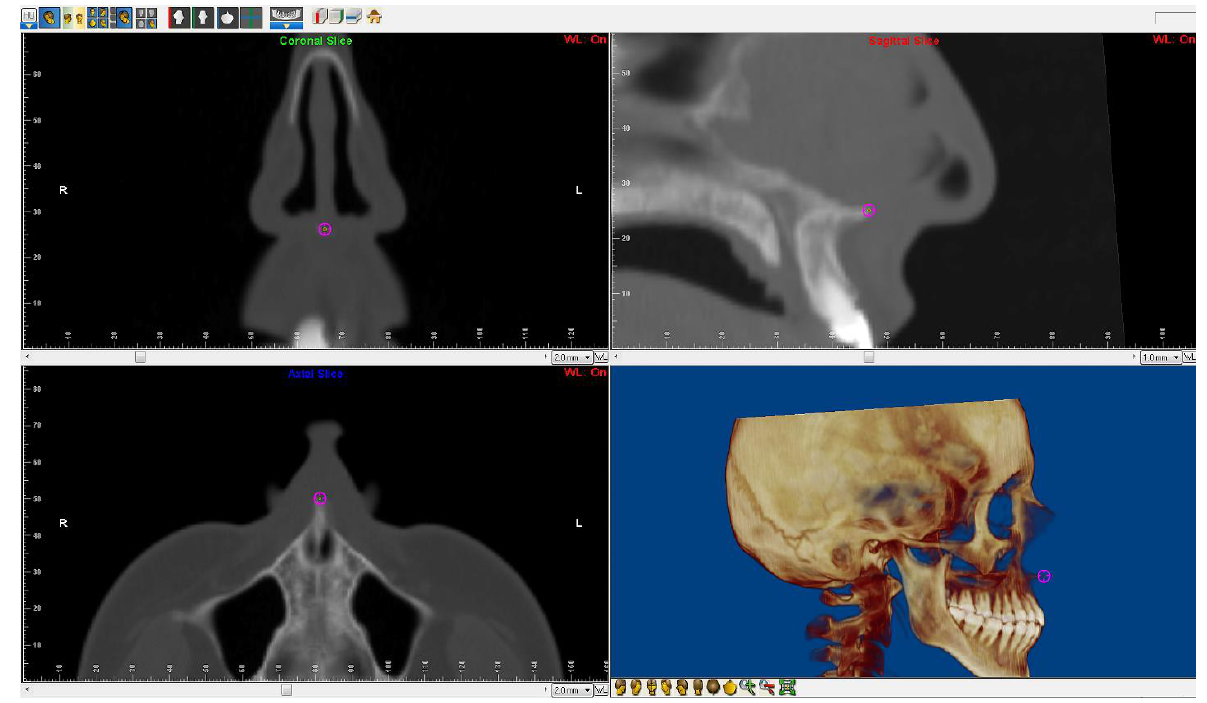
Figure 2. Identification of ANS reference point (anterior nasal spine) in all three planes of space.